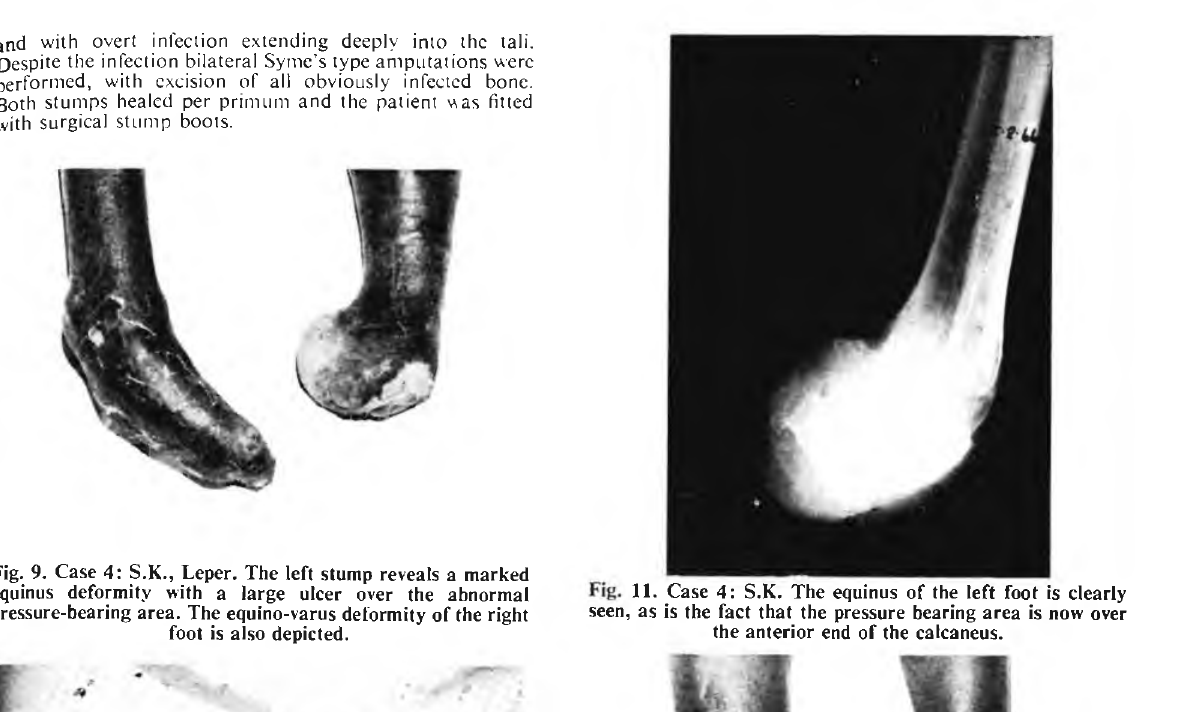
Case 4: S.K. The equinus of the left foot is clearly is the fact that the pressure bearing area is now over the anterior end of the calcaneus.